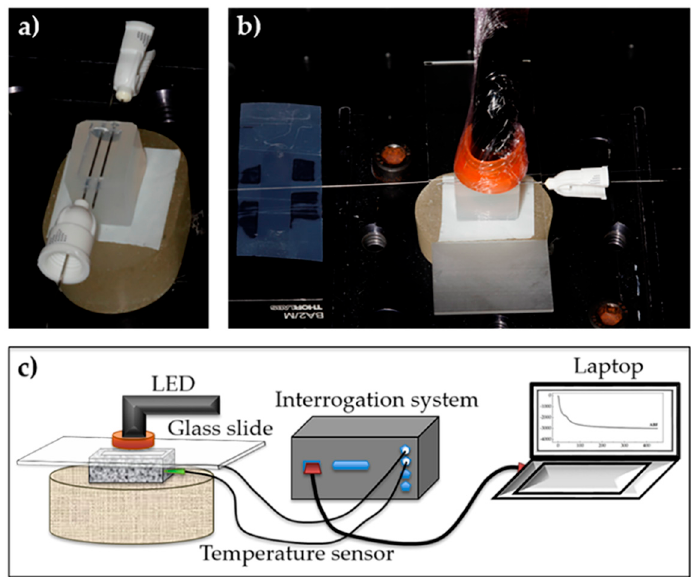
Figure 1. Photographs of the silicone mold with the two needles ( a ) and the light curing of the resin ( b ). Experimental setup used to assess the polymerization shrinkage of the RBCs ( c ).